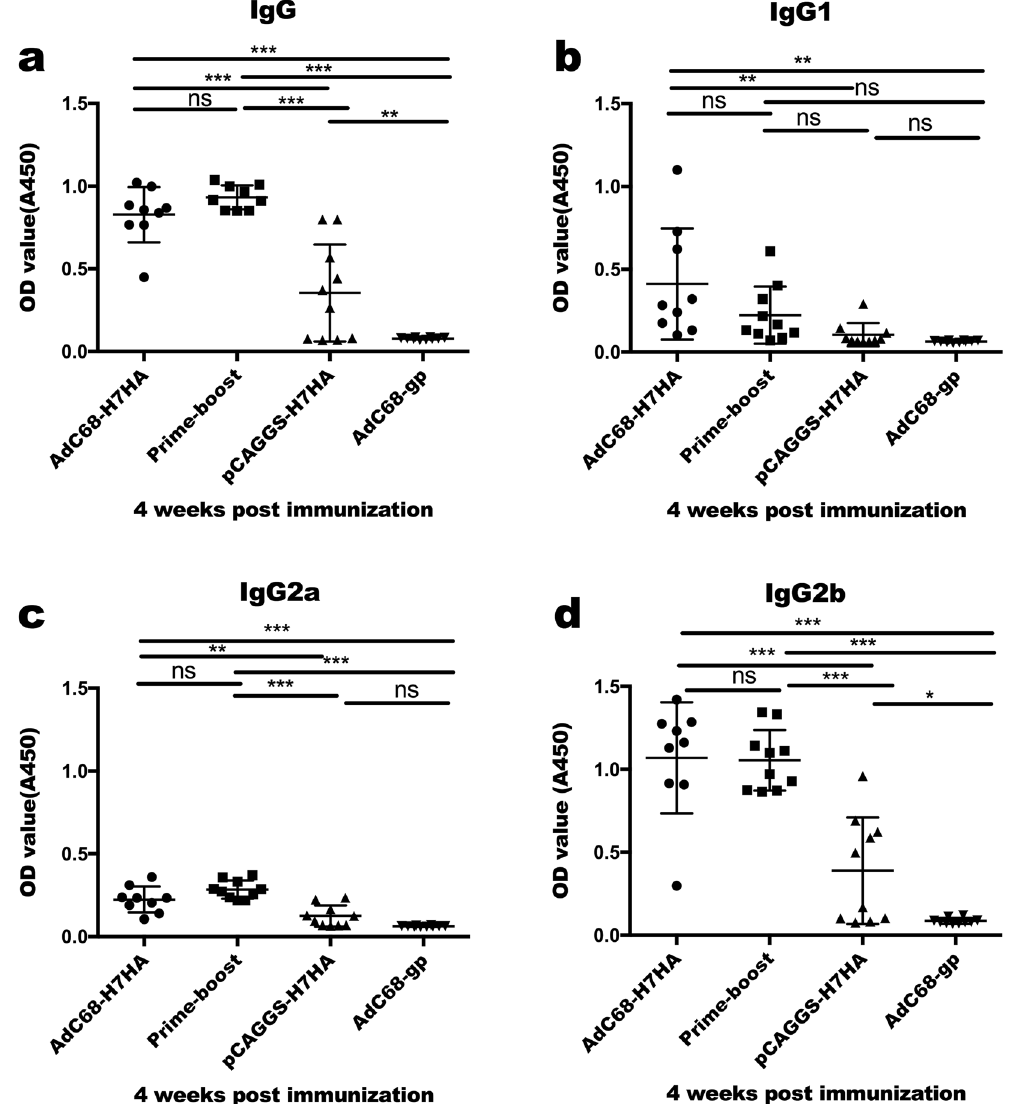
Figure 1. H7N9-specific IgG responses induced after immunization. C57BL/6 mice (8–10 animals/group) were divided into 4 groups: AdC68-H7HA group, pCAGGS-H7HA group, AdC68-gp group, and the DNA prime-adenovirus boost group (primed with pCAGGS-H7HA and boosted with AdC68-H7HA 2 weeks later). Four weeks after immunization, serum samples were collected for IgG detection. ( a ) IgG responses at 4 weeks after immunization. ( b ) IgG1 responses 4 weeks after immunization. (c) IgG2a responses 4 weeks after immunization. ( d ) IgG2b responses 4 weeks after immunization. The error bars represent the standard deviations (SD). *** p < 0.001; ** p < 0.01; * p < 0.05; ns, not